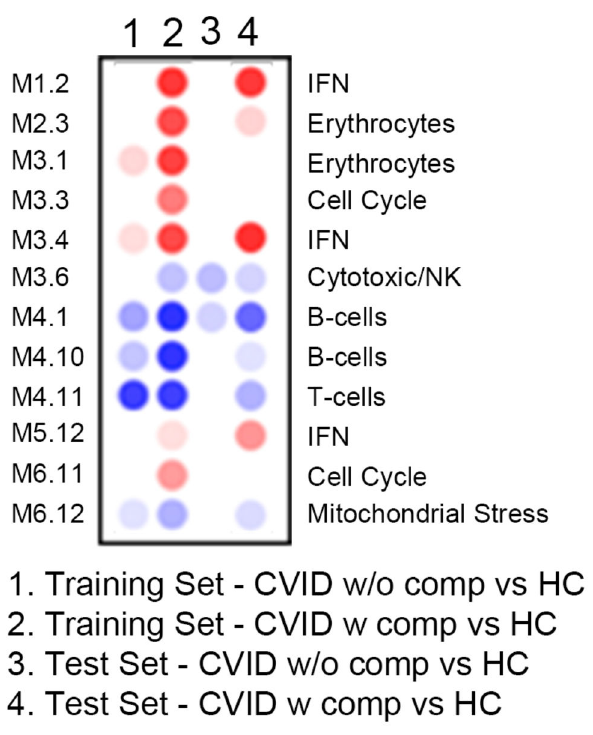
Figure 8. Statistically significant modules from both training and test sets compared to healthy controls. Columns are as labeled for subjects with or without complications vs. healthy controls